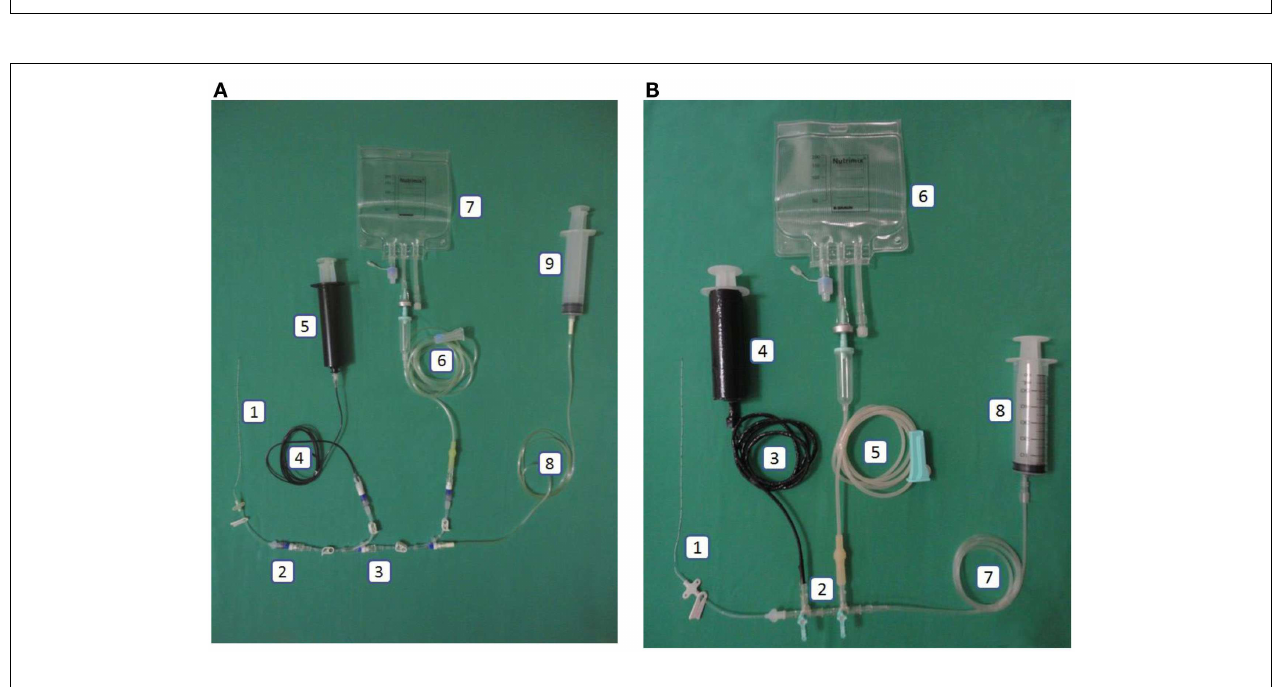
FIGURE 2 | (A) Intervention: central line in the closed catheter access system. 1. Peripherally inserted central catheter, 2. Single needleless connector, 3.Triple lumen NCs with luer lock, 4. Extension tube luer lock (black), 5. Luer lock syringe 50mL (black), 6. Infusion set luer lock, 7.Total parenteral nutrition bag, 8. Extension tube luer lock, 9. Luer lock syringe.